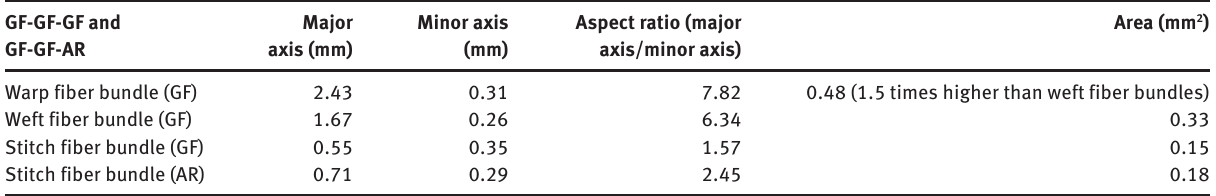
Table 4 Internal structure of warp, weft, and stitch